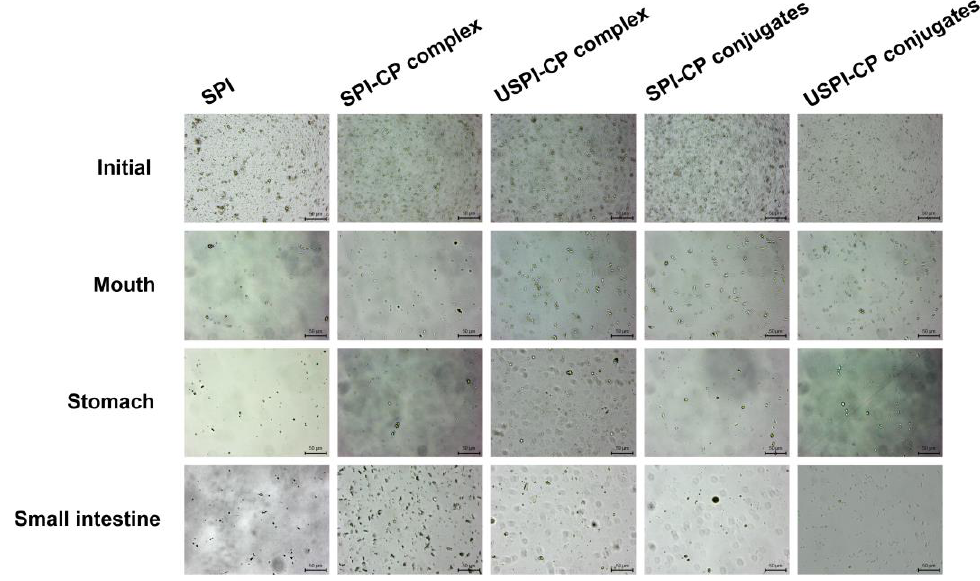
Figure 3. Optical micrographs of β -carotene nanoemulsions stabilized by different emulsifiers at different in vitro simulated digestion phases. Samples: SPI, soy protein isolate; SPI–CP complex, electrostatic complex formed between soy protein isolate and citrus pectin; USPI–CP complex, electrostatic complex formed between soy protein isolate and citrus pectin with ultrasound treatment; SPI‒CP conjugate, Maillard-type conjugate formed between soy protein isolate and citrus pectin; USPI‒CP conjugate, Maillard-type conjugate formed between soy protein isolate and citrus pectin with ultrasound treatment.